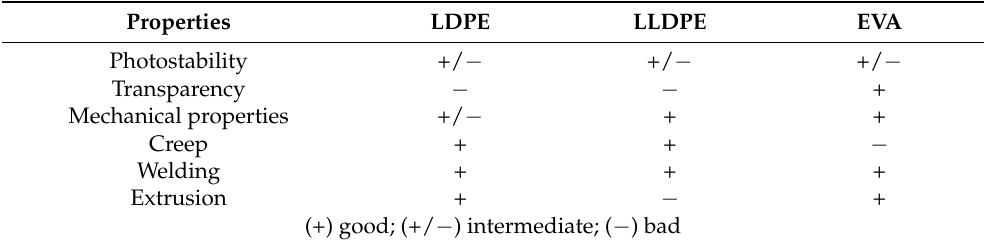
Table 6. Main properties of the polymers used in agricultural plastic films applications. Adapted from [86]. Properties LDPE LLDPE EVA